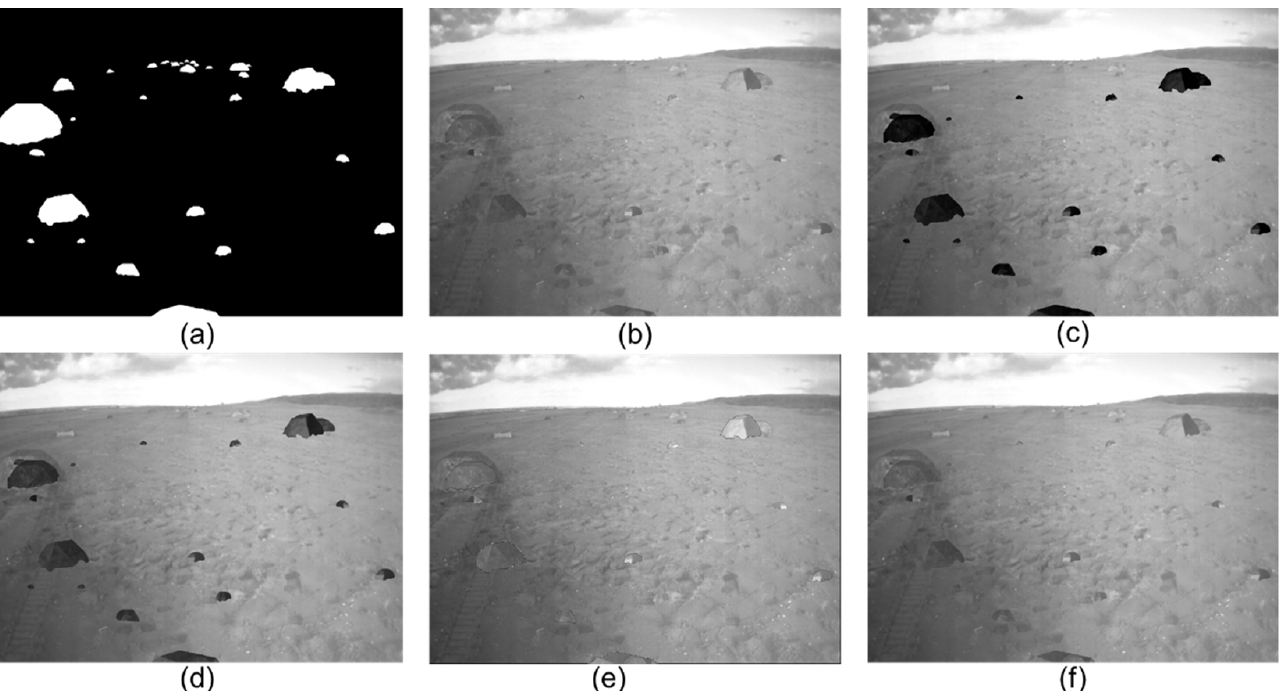
Figure A1. The visualized results of the experiments for the constant C in Table 2. ( a ) refers to the synthetic annotation, while ( b – f ) corresponds to the synthetic images through different settings of C . ( b ) applies the same setting as Table 2. ( c ) keeps the grade setting but increases the range of the C , the maximum C is set to 250. ( d ) refers to the results of only increasing maximum C to 150. ( e ) refers to the results of decreasing maximum C to 20. ( f ) keeps the maximum C as the same as ( b ), while the grade setting applies 21 grades.